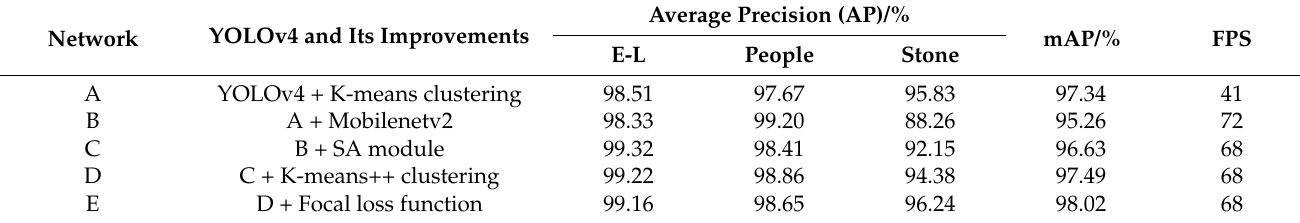
Table 4. Ablation experiment results.